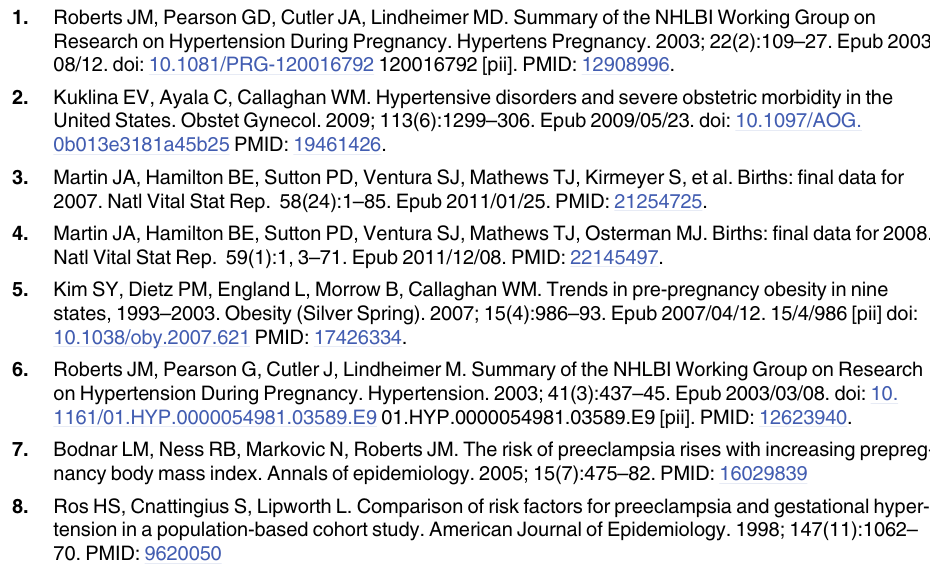
S1 Table. Characteristics of Women with and without Information on Body Mass Index during early pregnancy. Abbreviations: BMI, body mass index; p-value, Fisher Exact Test for difference in proportions between BMI availability. S2 Table. Association of Smoking with Hypertensive Disorders during Pregnancy Strati- fied by BMI. Abbreviations: BMI, body mass index; CI, confidence interval; HTD, hyperten- sive disorder of pregnancy; OR, odds ratio. (cid:3) Adjusted for parity, multiple gestation and maternal age. Cases and controls gave birth in the same calendar year. All cases and controls are restricted to women without any registered diabetes during pregnancy. S1 Fig. Mean Blood Pressure (mm Hg) by Diagnosis of Hypertensive Disorder during Preg- nancy. (A) Controls (no hypertensive disorder during pregnancy) vs. cases (any hypertensive disorder during pregnancy). (B) Controls (no hypertensive disorder during pregnancy) vs. cases (pre-existing hypertension, gestational hypertension or preeclampsia). Abbreviations: SBP, systolic blood pressure; DPB, diastolic blood pressure. (cid:3) Mean values of mm Hg are adjusted for parity, multiple gestation and maternal age in with linear regression models. Beta values demonstrate the adjusted the difference of mean mmHg value by